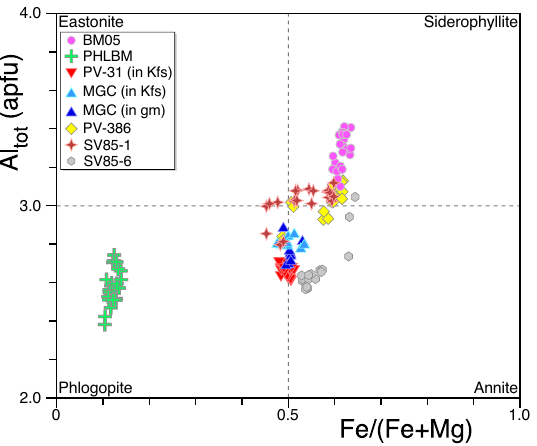
Figure 3. Compositional variations of trioctahedral micas [Al IV vs Fe/(Fe + Mg) plot] from the Campiglia Marittima magmatic-hydrothermal